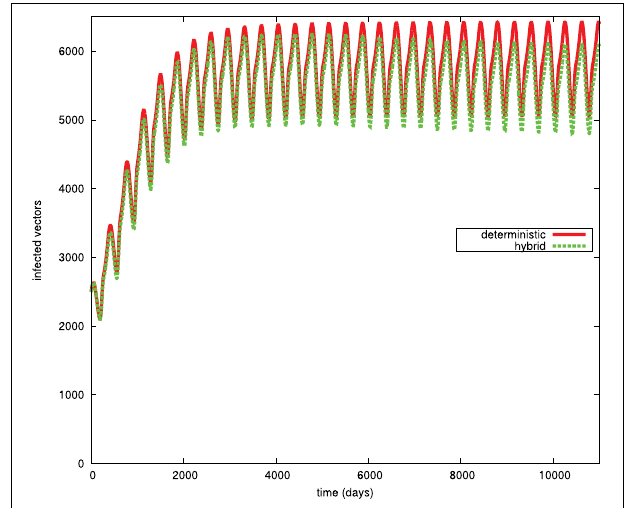
FIGURE 9 | Simulation results for the infected vector population ( V i ) in the deterministic and hybrid setting. V i oscillates in the hybrid setting at slightly lower amplitude than in the purely deterministic setting.